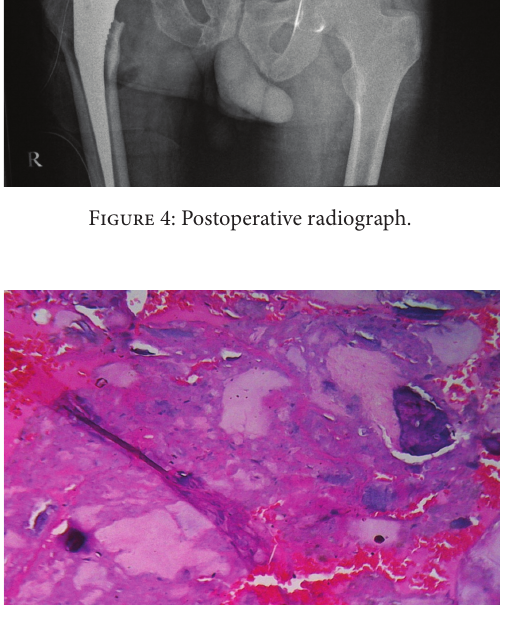
F 5: Histopathology slide showing necrotic bone with repara- tive �broblastic